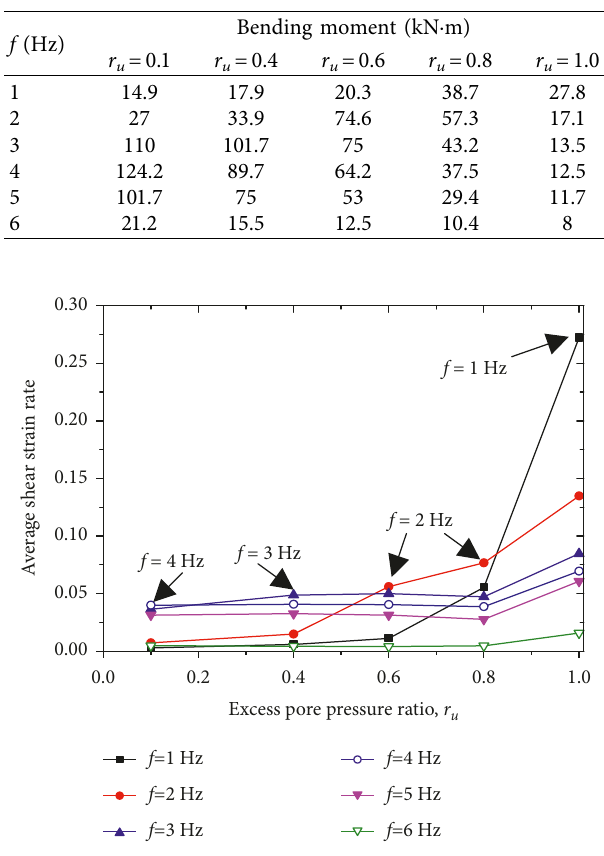
Figure 11: Shear strain rate versus pore pressure ratio for different loading